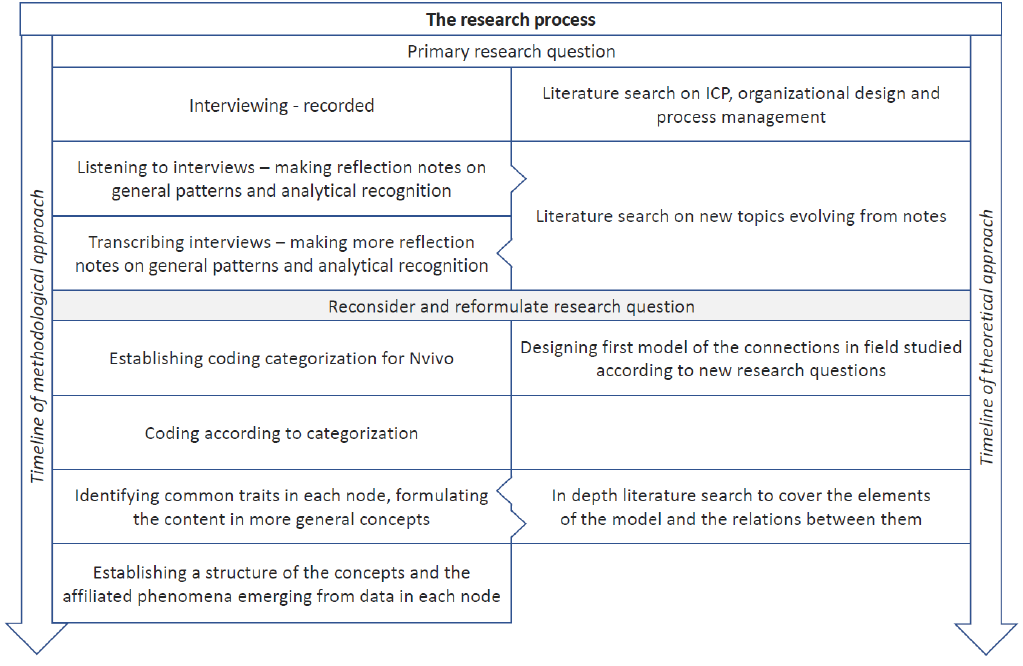
Figure 2. Schematic description of the abductive research process.